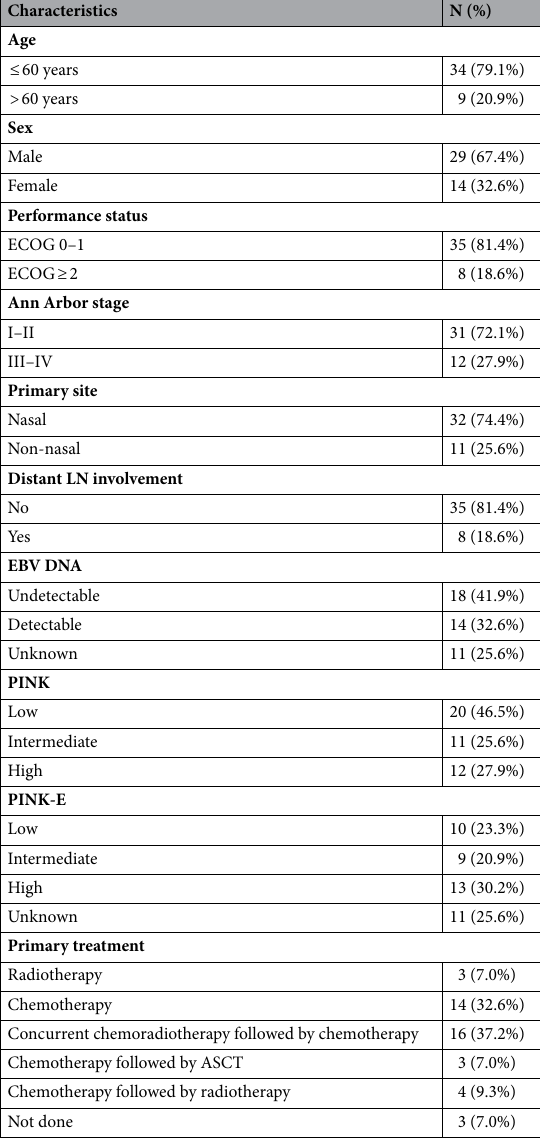
Table 1. Patients characteristics (n = 43). ECOG Eastern Cooperative Oncology Group, LN lymph node, EBV Epstein–Barr virus, PINK prognostic index for natural killer cell lymphoma, PINK-E prognostic index for natural killer lymphoma–Epstein–Barr virus, ASCT autologous stem-cell